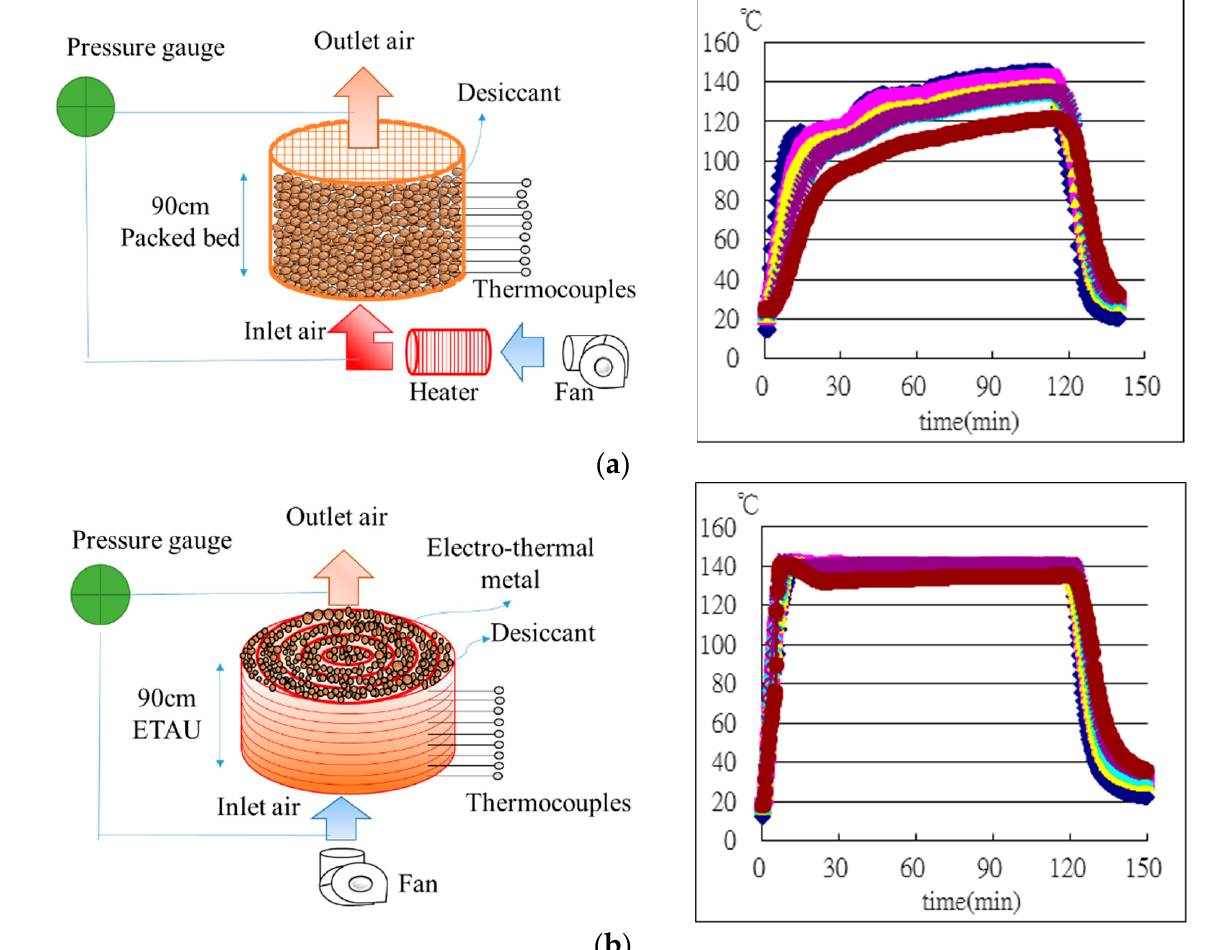
Figure 14. Temperatures at different heights in ( a ) a conventional heated-air-flow system and ( b ) the proposed ETAU system. Table 4. The procedure of the compressed air drying